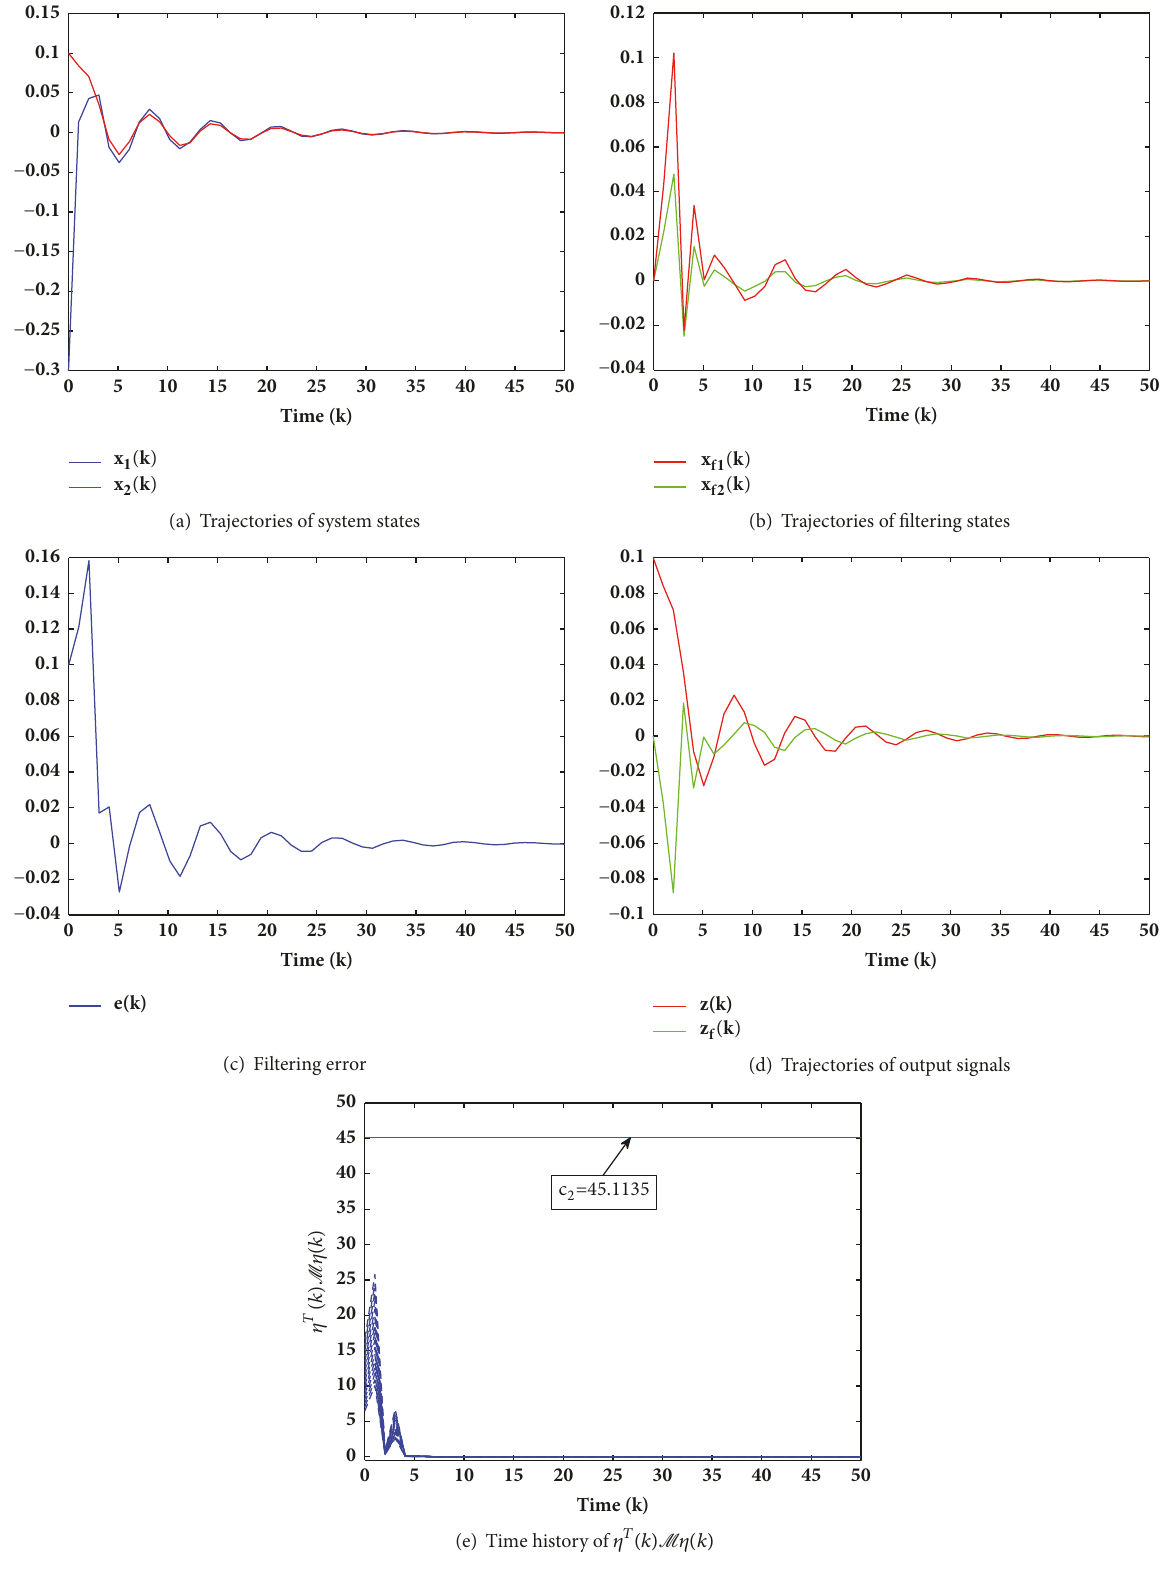
Figure 1: Simulation results of Example